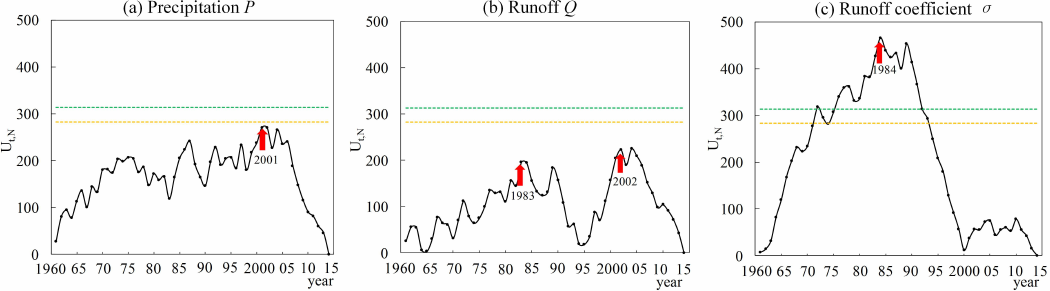
Figure 3. Temporal distributions of the test statistic U t,N estimated by the Pettitt test applied to time series of precipitation P in panel ( a ), runo ff Q in panel ( b ) and runo ff coe ffi cient σ in panel ( c ) during the period 1961–2014. Significance levels of 5% and 10% are represented by the upper and lower broken lines,